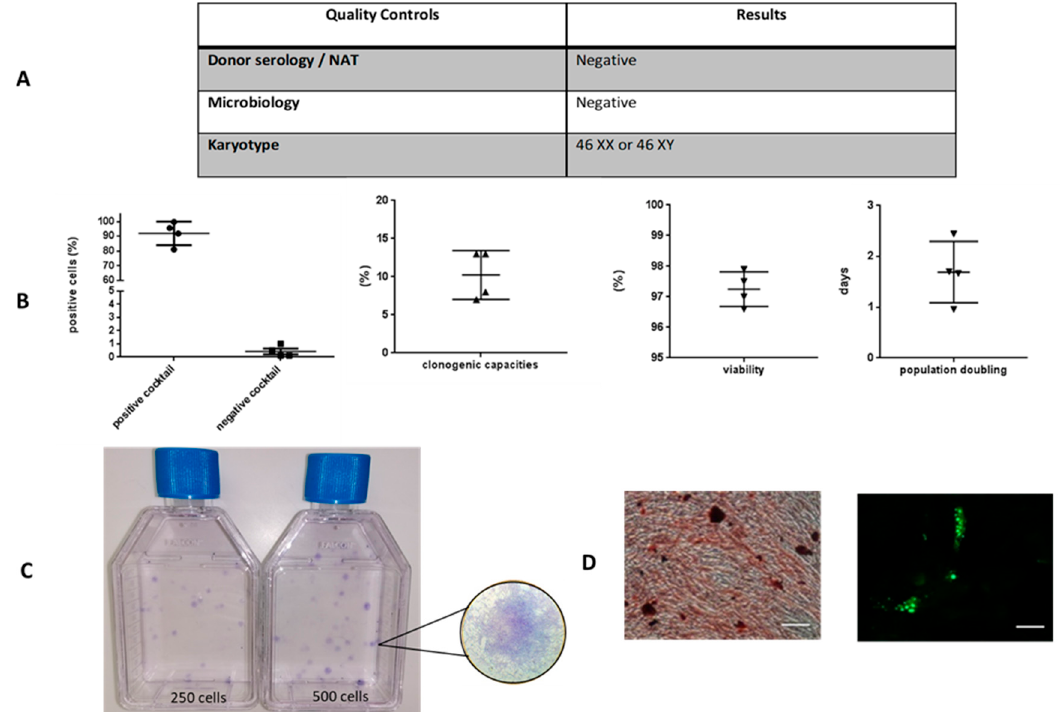
Figure 1. Characterization of Wharton jelly-mesenchymal stem / stromal cells (WJ-MSCs) at the end of Good Manufacturing Practice (GMP) expansion (passage 3). Serology, Nucleic acid test (NAT), microbiology and karyotype ( A ) were determined for all cords. Graphics represent positive (Cluster of Di ff erentiation 90 (CD), CD105, CD73, and CD44) and negative (CD45, CD34, CD11B, CD19, and Human Leukocyte Antigen (HLA) DR) cocktails, percentage of clonogenic capacities, viability and population doubling in days ( B ). Representative clonogenic capacity ( C ) and osteogenic and adipogenic di ff erentiation are presented in ( D ). Scale bars correspond to 100 µ m. Data are expressed as mean ± SD ( N = 4 independent cords).